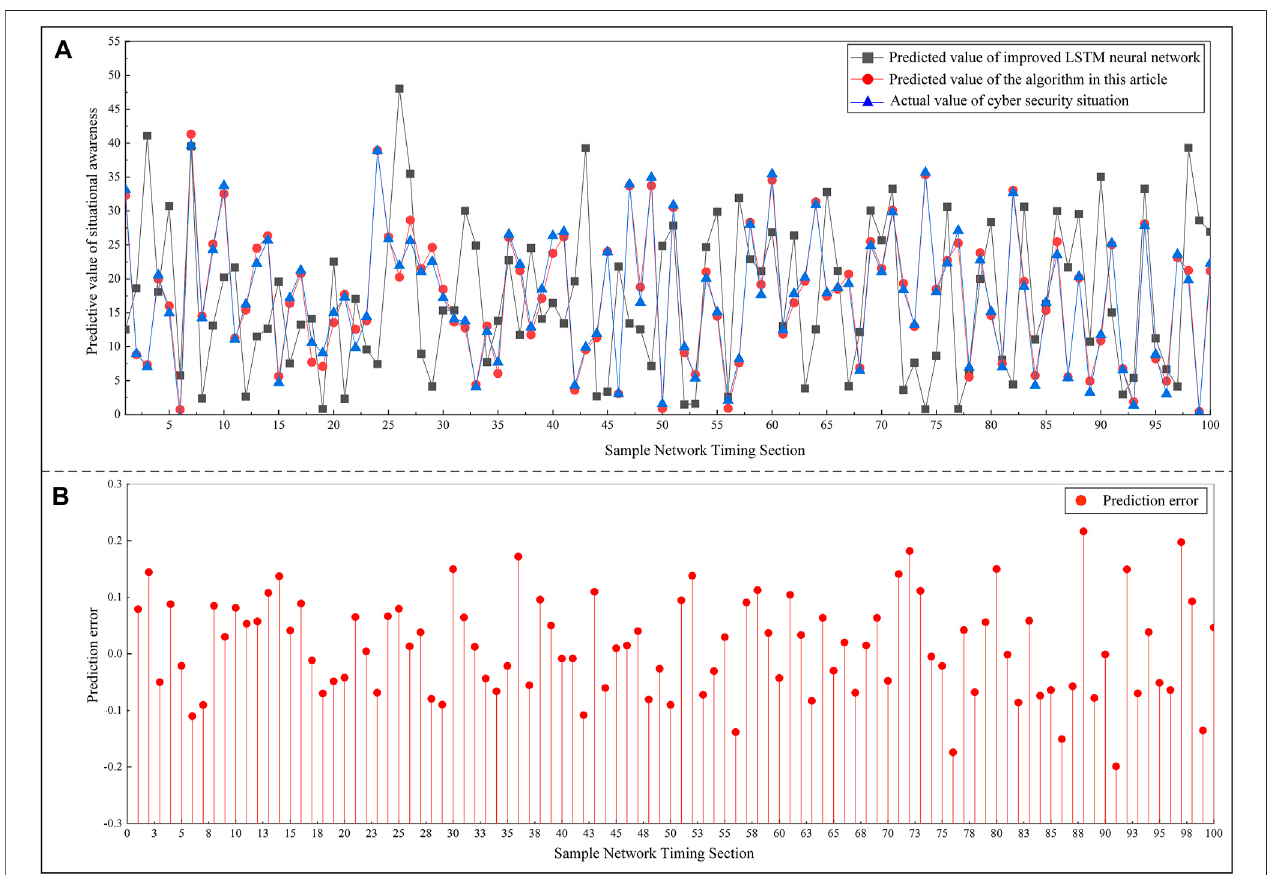
FIGURE 4 | Comparison experiment of network security situation quanti fi cation results: (A) Comparison between the predicted value and the actual value. (B) Prediction